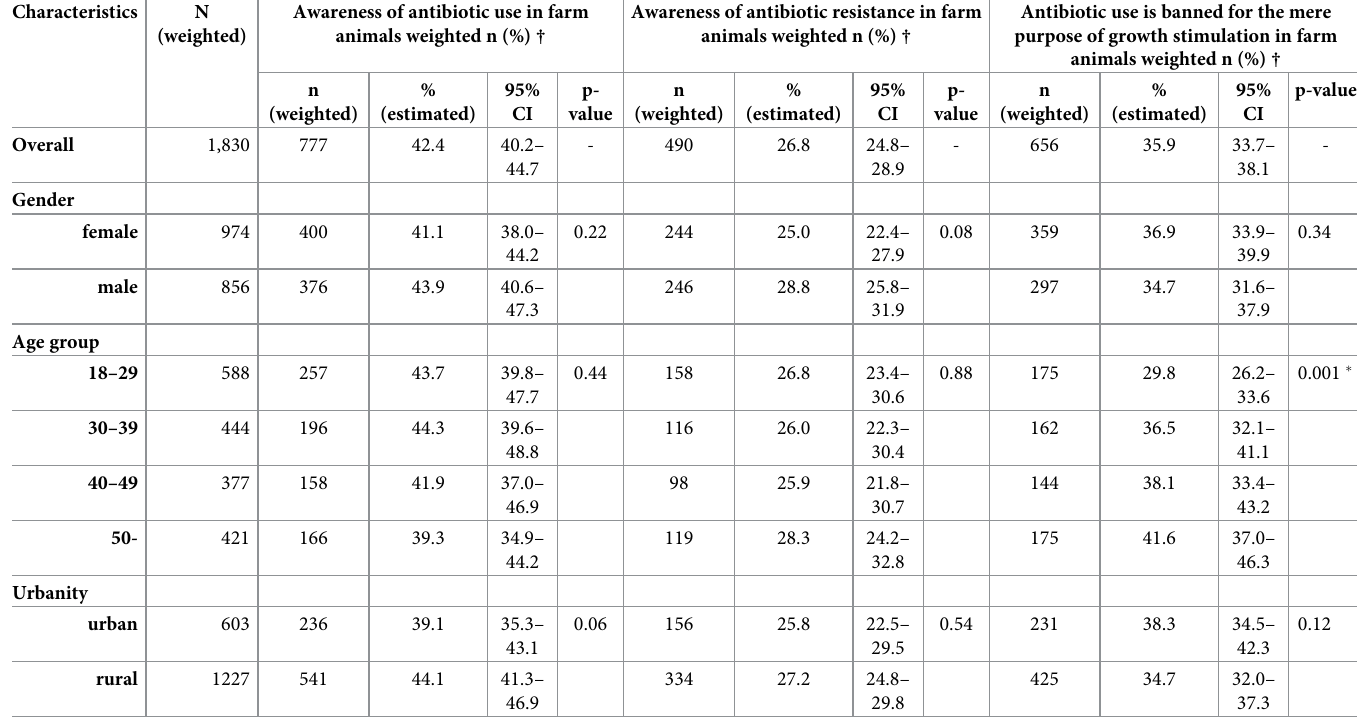
Table 6. Awareness of antibiotic use and resistance in farm animals (N = 1,830).